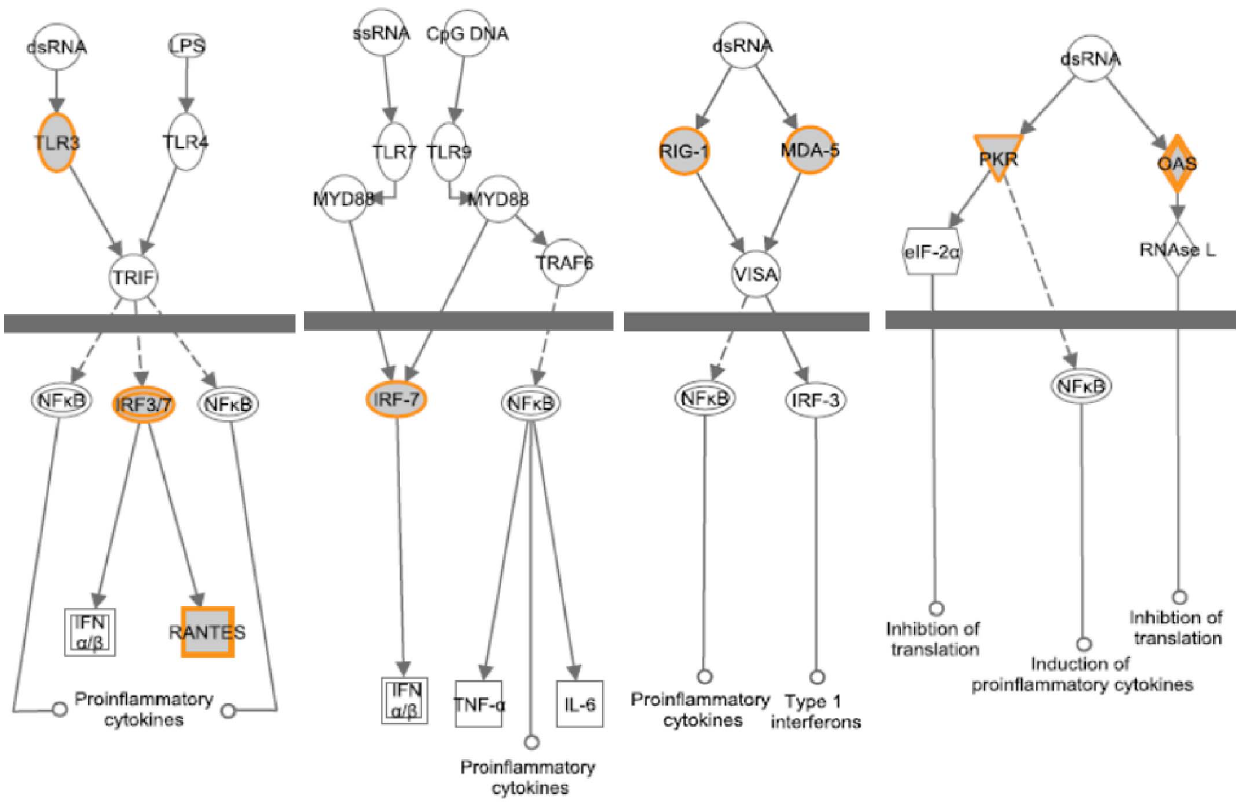
Figure 4. Genes in the pattern recognition receptor pathway are associated with IFN responsiveness. The gene network was generated using Ingenuity Pathway Analysis software. Genes upregulated in nonresponders (shown in Figure 1) were highlighted. As expected, several antiviral signaling pathways were overrepresented in these genes.